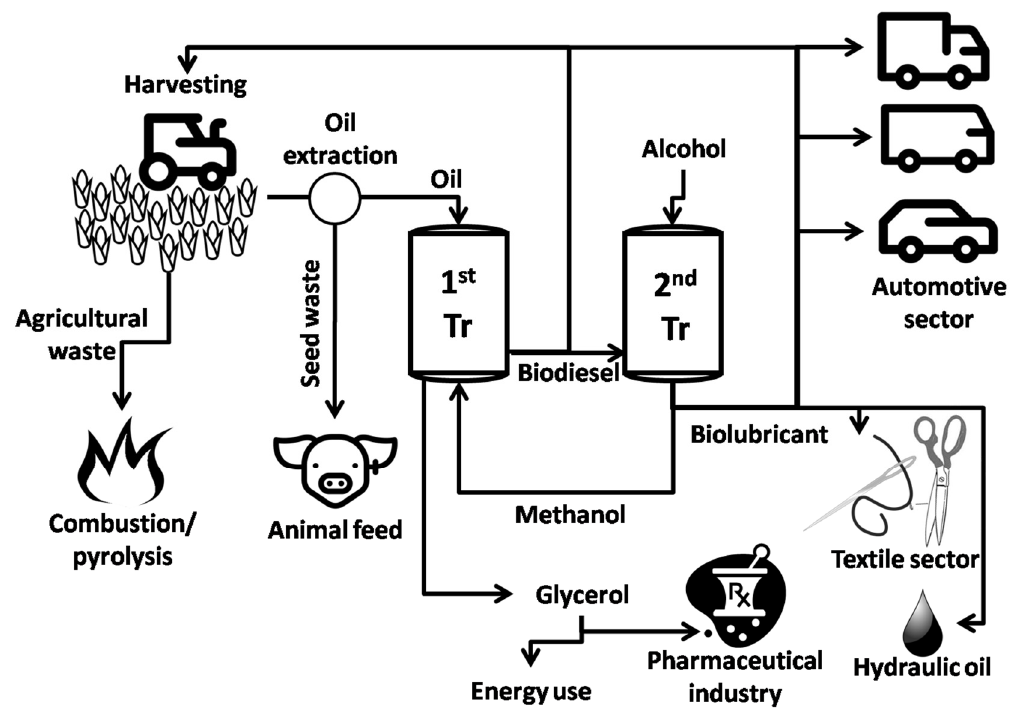
Figure 14. Biorefinery based on cardoon, where 1stTr and 2ndTr are first and second transesterification, respectively. Icons provided by Ilham Albab, Ionescu Georgiana Lavinia and Anthony Ledoux (iconfinder).